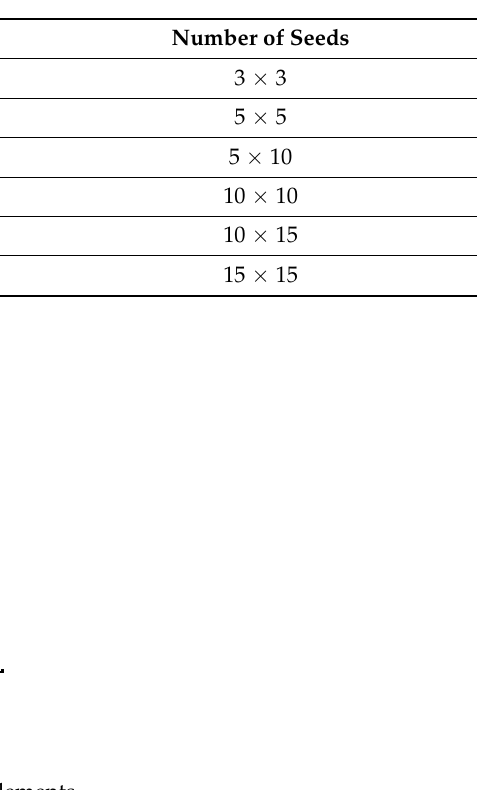
Table 3. Soil element number.